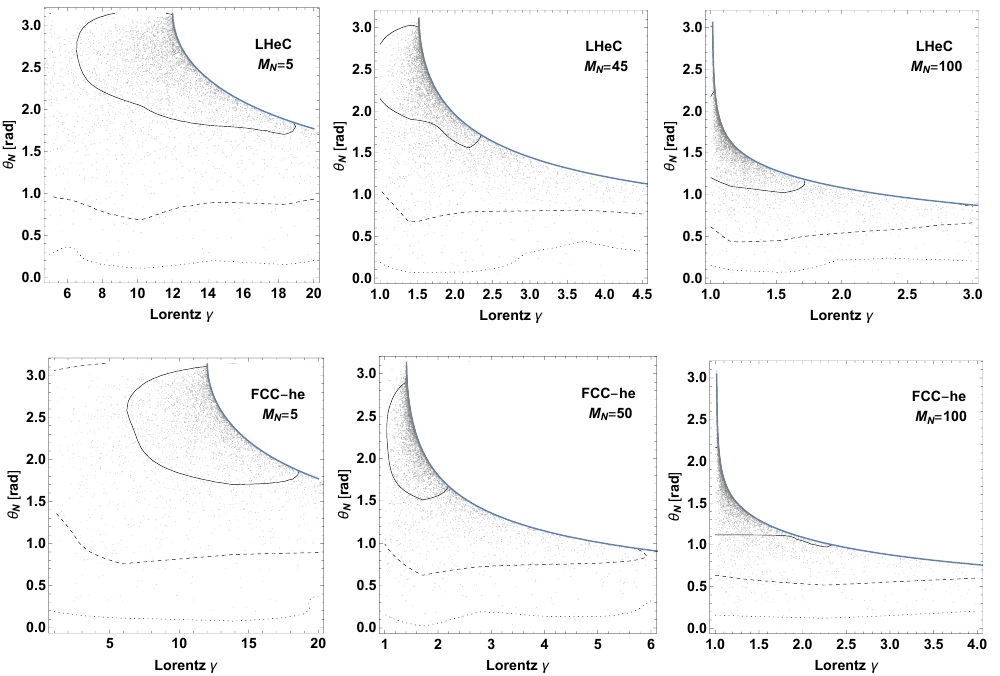
Figure 2 . Kinematics of the heavy neutrino produced in electron-proton collisions at the LHeC (upper row) and at the FCC-he (lower row). All masses are in GeV, the proton is in direction of (cid:18) = 0. The plots show the distribution of the scattering angle (cid:18) N (10 4 events, shown as black dots) of the heavy neutrino with respect to the beam axis versus the Lorentz boost factor (cid:13) . The black solid, dashed, and dotted line show the density contours with 68%, 95%, and 99% of the points inside the contour